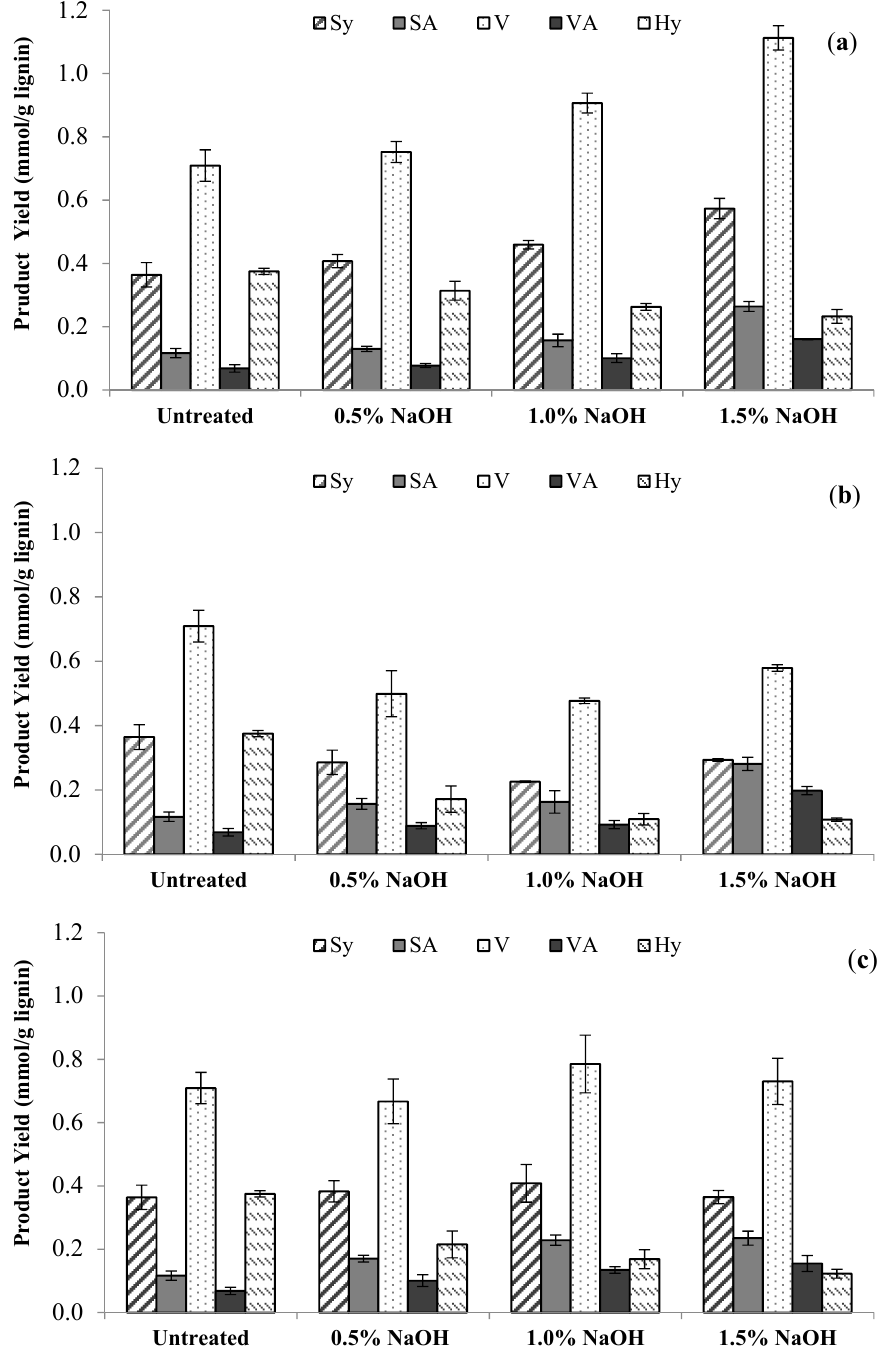
Figure 2. Production of degradation compounds through nitrobenzene oxidation of switchgrass samples (mmol/g lignin) pretreated for ( a ) 15 min; ( b ) 30 min; and ( c ) 60 min.